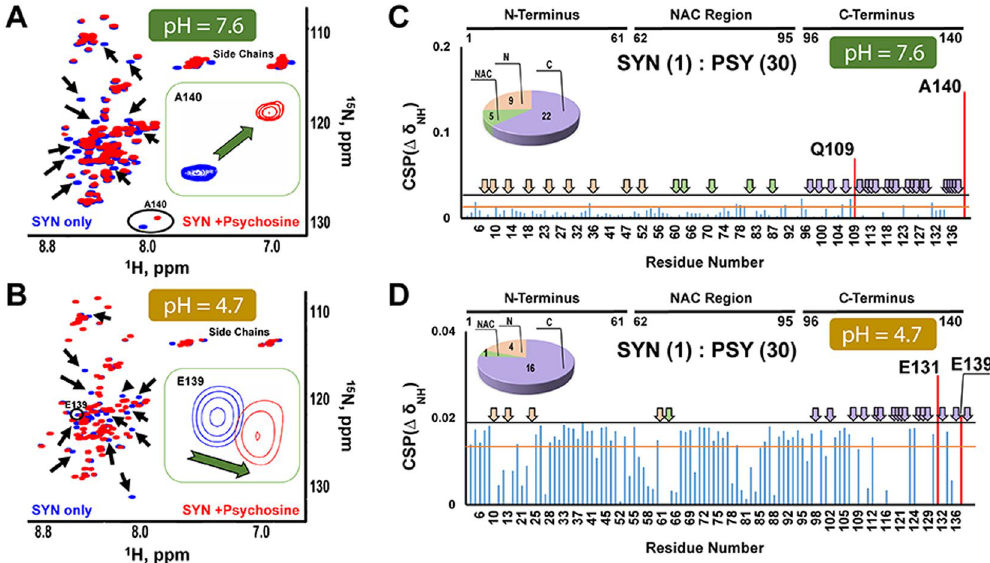
Figure 5. Psychosine interacts with α -synuclein at cytoplasmic (neutral) and lysosomal (acidic) pH. Overlays of 1 H 15 N-HSQC NMR spectra of α -synuclein (blue) with α -synuclein (1) psychosine (30) (red) at pH 7.6 ( A ) and α -synuclein (1) psychosine (30) (red) at pH 4.7 ( B ). Examples of chemical shift changes are circled and highlighted in a box. Black arrows indicate areas of signal broadening. The CSPs were measured from the spectra α -synuclein (1) psychosine (30) (red) at pH 7.6 ( C ), and α -synuclein (1) psychosine (30) (red) at pH 4.7 ( D ). The black horizontal line represents the mean CSP plus one SD. The orange horizontal line represents the maximum CSP due to spectral variability between different samples of α -synuclein. CSPs higher than both the black and orange lines were considered significant and are marked in red. The broadened- beyond-detection signals were assigned by arrows marked in pink in the N-terminus, green in the NAC region, and purple in the C-terminus. The number of signals that were broadened are presented in a pie chart. PSY = psychosine; SYN = α